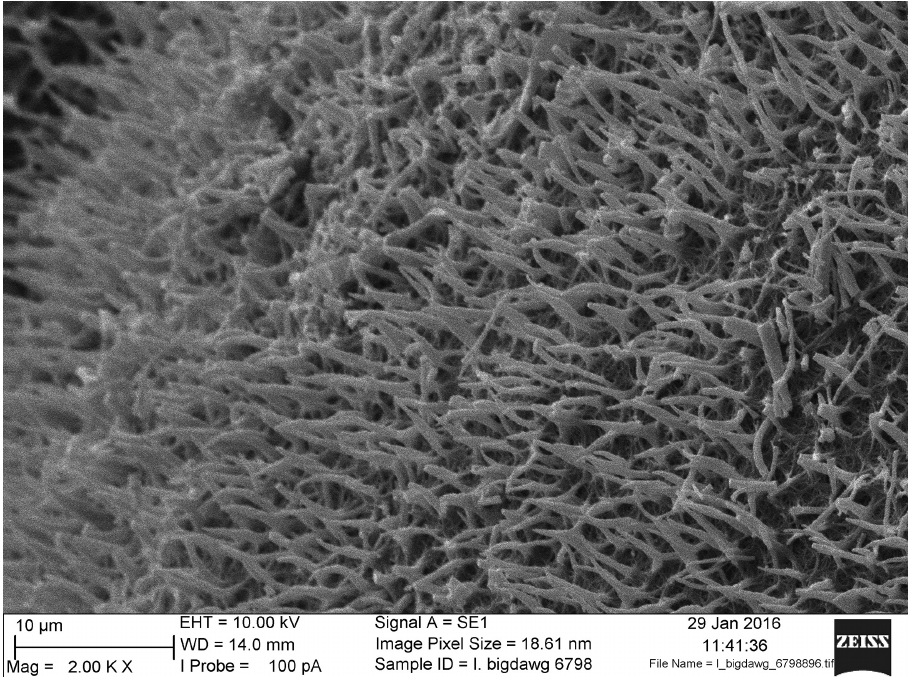
Figure 2. SEM detail of megaspore micro-ornamentation. Magnification